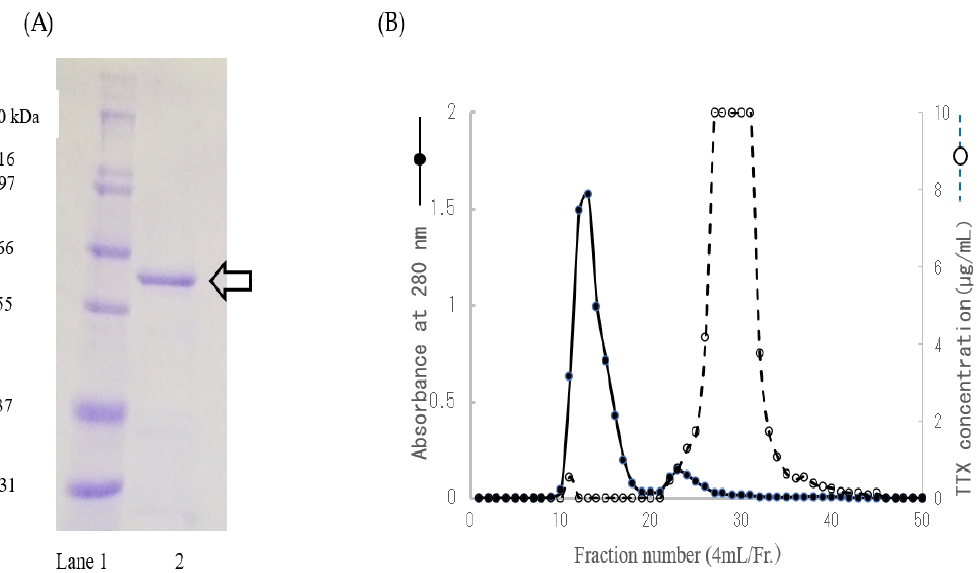
Figure 6. Recombinant protein of TTX-binding protein subunit-2, rHSTBP sub-2: ( A ) SDS-PAGE, lane 1: marker; lane 2: sample; white arrow indicates recombinant protein of TTX-binding protein subunit-2, rHSTBP sub-2; ( B ) Sephacryl S-300 column chromatography; Sample: recombinant protein of TTX-binding protein subunit-2, rHSTBP sub-2, mixed with TTX; column: Sephacryl S-300 (2 × 29 cm); mobile phase: 0.02 M Tris-acetic acid ( ⇒ Change to ”acetate”) buffer (pH 7.4); flow rate: 0.5 mL/min. Fraction: 4 mL/Fr.